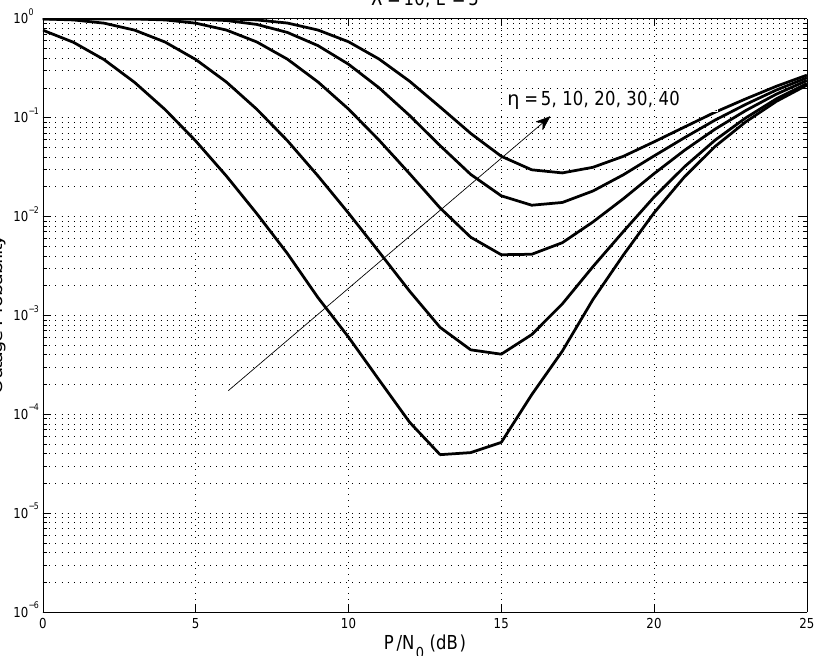
Figure 5. Outage probability of the system with L = 5 for interference constraint λ = 10 and outage threshold η = 5, 10, 20, 30,